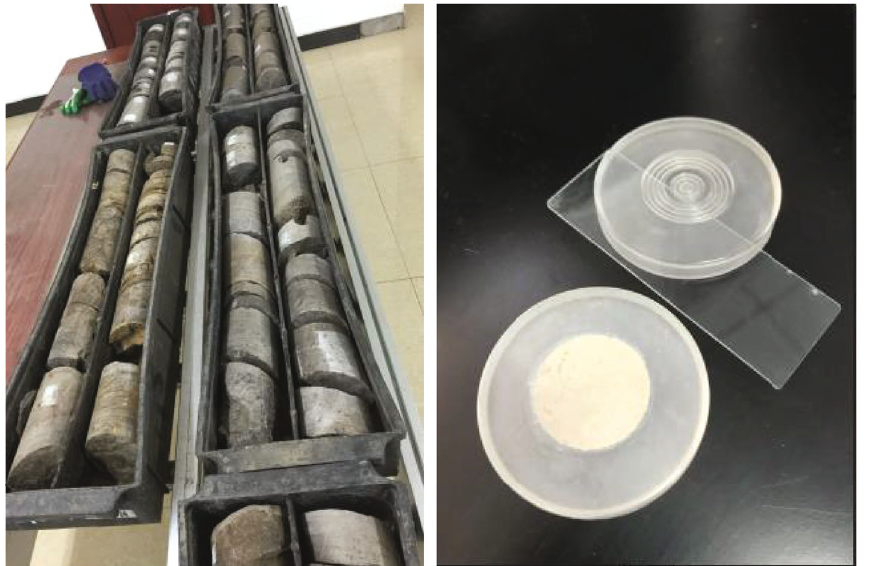
Figure 9: The core